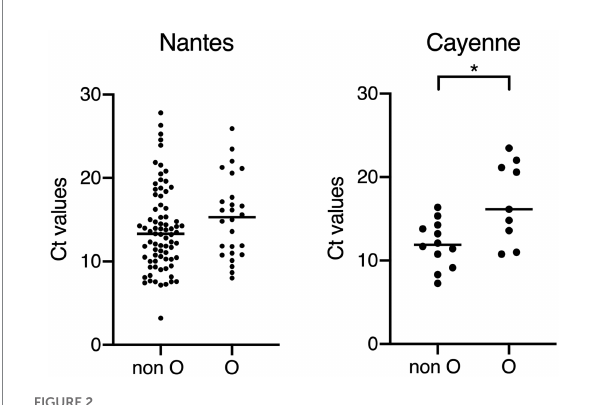
FIGURE 2 Comparison of Ct values between children of the O and non-O blood groups. Non-O blood groups correspond to A, B and AB blood groups. All samples for which Ct values could be obtained are shown, regardless of the availability HBGA or clinical severity scores. Higher Ct values correspond to lower amount of detected viral RNA, suggesting lower viral excretion and association with lower clinical severity of AGE (Bonacorsi et al., 2021). * p <